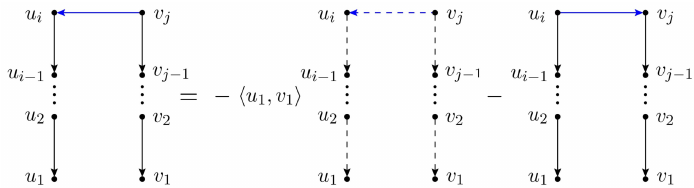
Figure 3 . Transformation-1 of the bridge of spanning forest (The type-2 edge in the same direction as the type-1 edge is accompanied by the reference spinor ζ , while the type-2 edge in the opposite direction to the type-1 edge is accompanied by the reference spinor χ .)